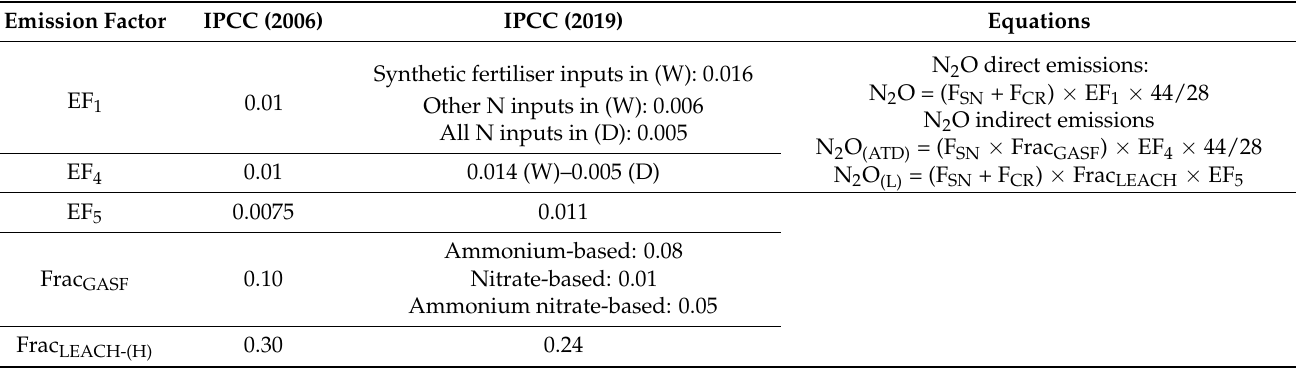
Table 2. Emission factors from barley production under wet (W) and dry (D) climates. N 2 O direct and indirect emissions. Emission